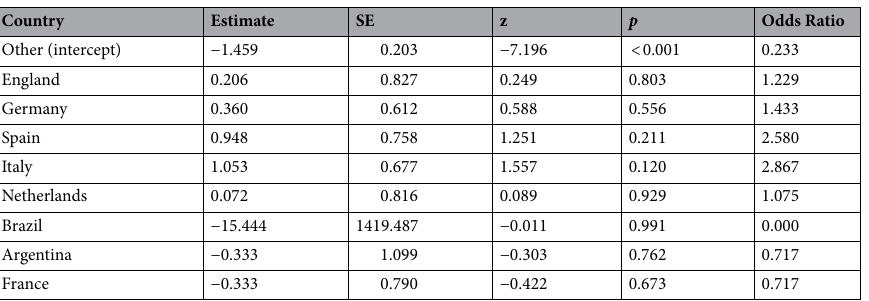
Table 2. Coefficients for the different nationalities in the binomial regression model for all in-game penalty kicks faced by goalkeepers during World Cup and European Championship matches (48 of 237 penalty kicks were missed against 142 different goalkeepers in the analyzed time periods). In the analyzed time periods, Brazilian goalkeepers saved none of the in-game penalty kicks they faced.